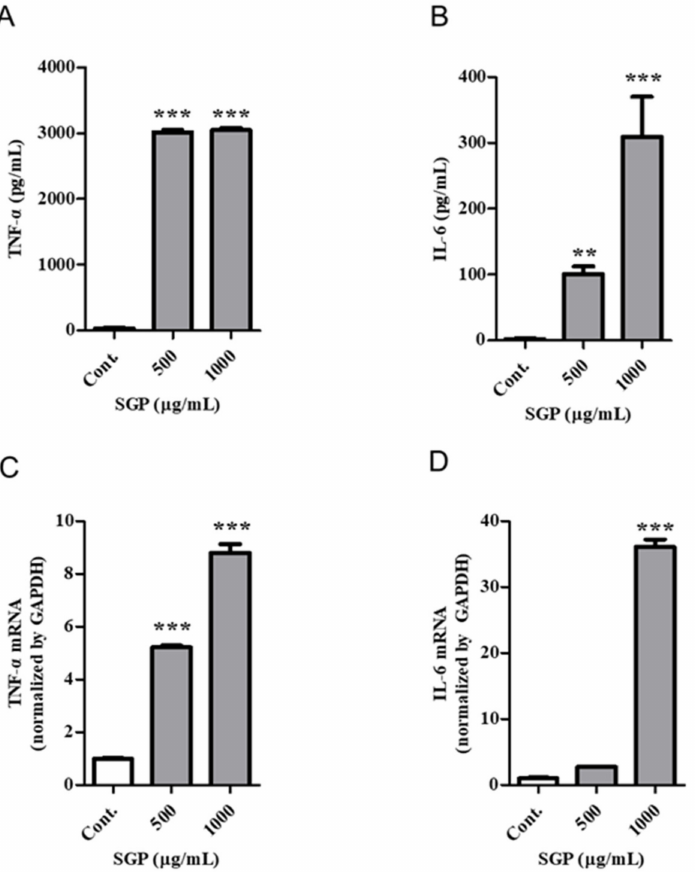
Figure 5. Effect of SGP on cytokine production and mRNA levels of IL-6 and TNF- α in RAW264.7 macrophages. RAW264.7 cells were stimulated with SGP at 500 and 1000 µ g/mL for 24 h. Production of IL-6 and TNF- α was determined using an ELISA ( A , B ). RAW264.7 cells were stimulated with SGP at 500 and 1000 µ g/mL for 12 h, and IL-6 and TNF- α mRNA levels were determined using RT-qPCR ( C , D ). Shown are the means ± SD of triplicate experiments. ** p < 0.001 and *** p < 0.0001, compared to the